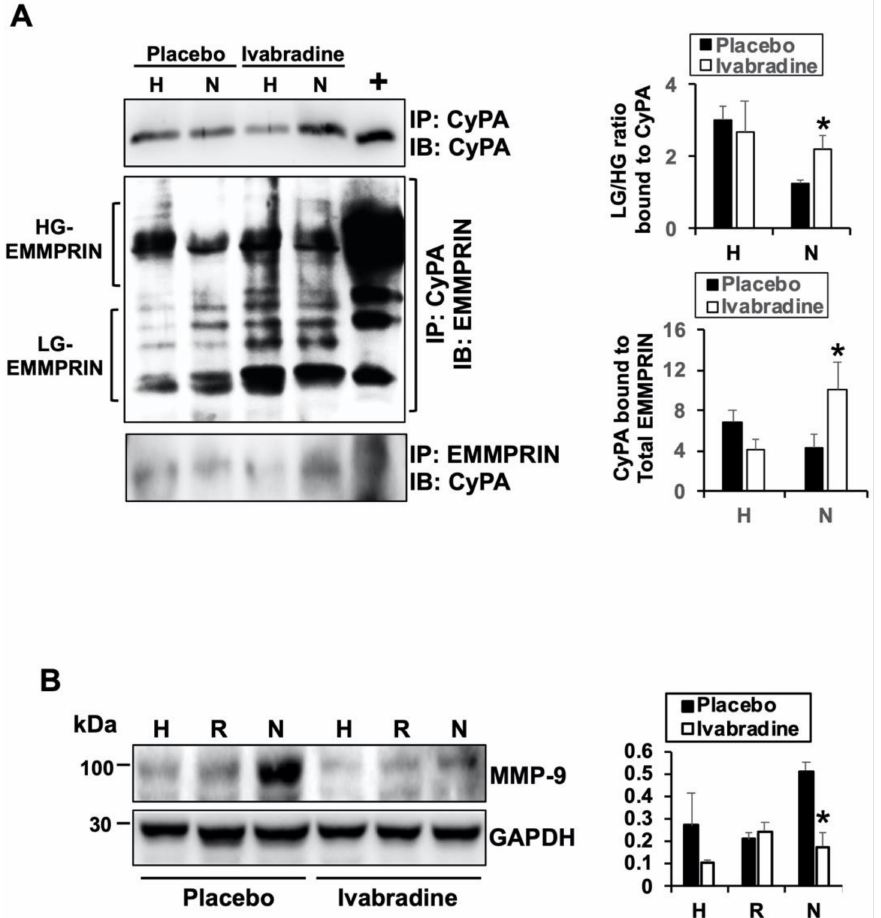
Figure 4. Ivabradine increases the binding between CyPA and low-glycosylated extracellular matrix metalloproteinase inducer (EMMPRIN). ( A ) Immunoprecipitation of CyPA and EMMPRIN in heart extracts ( n = 9 Ivabradine/8 placebo, mean ± SD, * p < 0.05 necrotic placebo vs. Ivabradine). ( B ) Immunoblot detection of MMP-9 and GAPDH as a loading control in heart lysates from placebo- and Ivabradine-treated pigs subjected to IR ( n = 9 Ivabradine/8 placebo. Mean ± SD, * p < 0.05 necrotic placebo vs.